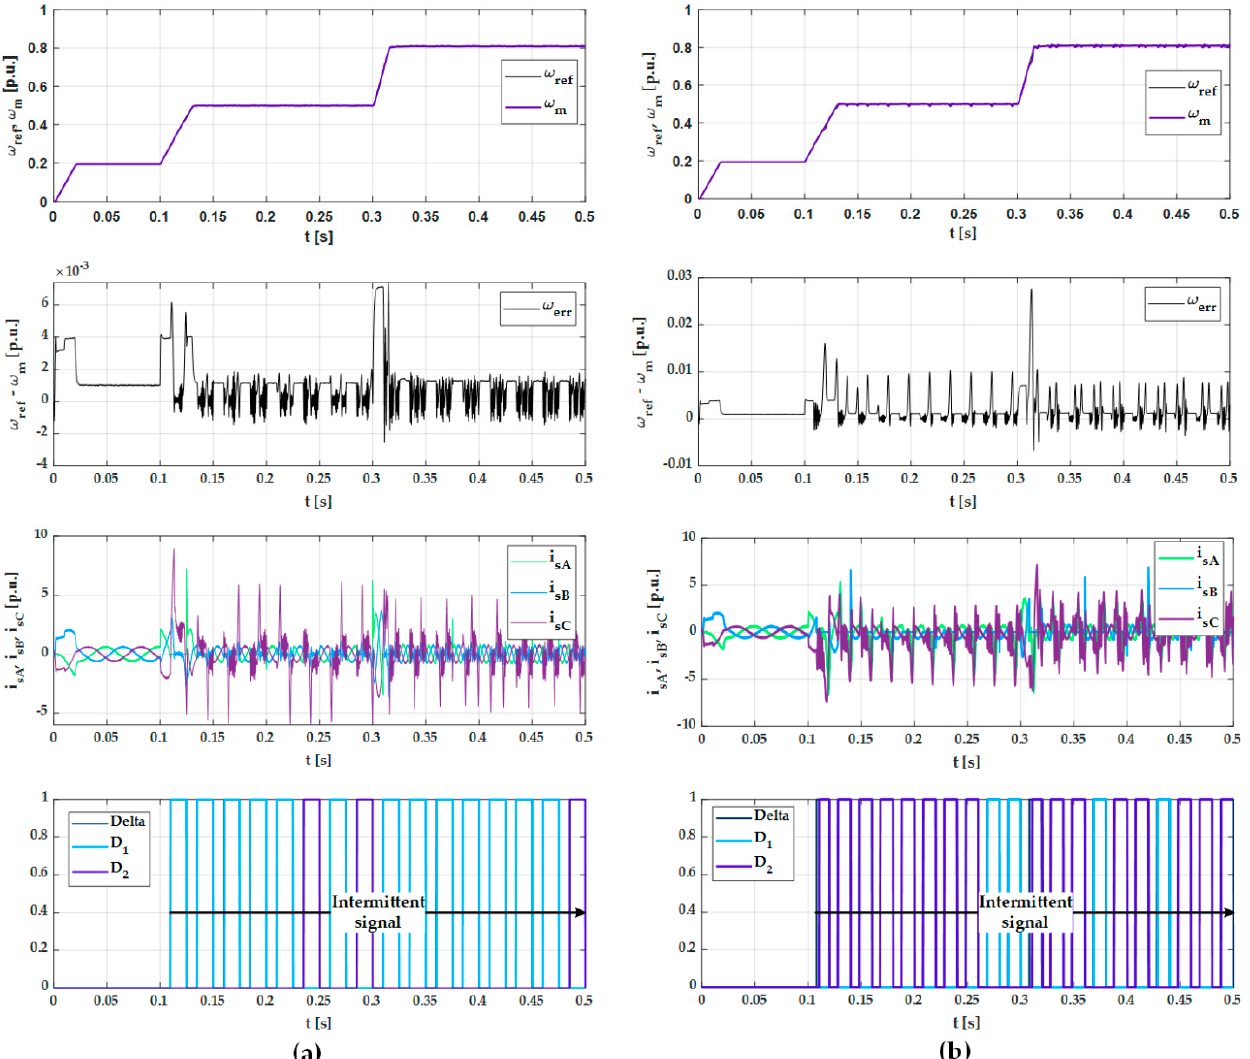
Figure 6. Detector responses obtained with a periodic signal interruption for different speed reference values for phase A ( a ) and phase B ( b ).